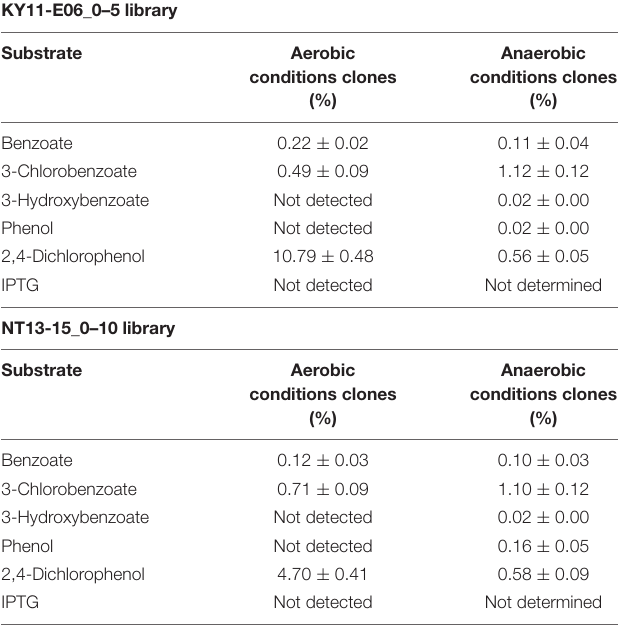
Values and errors represent the average and standard deviation of three independent experiments, respectively. The number of clonal variations was approximately 3 × 10 6 for both libraries. Not detected indicates 0.01% or